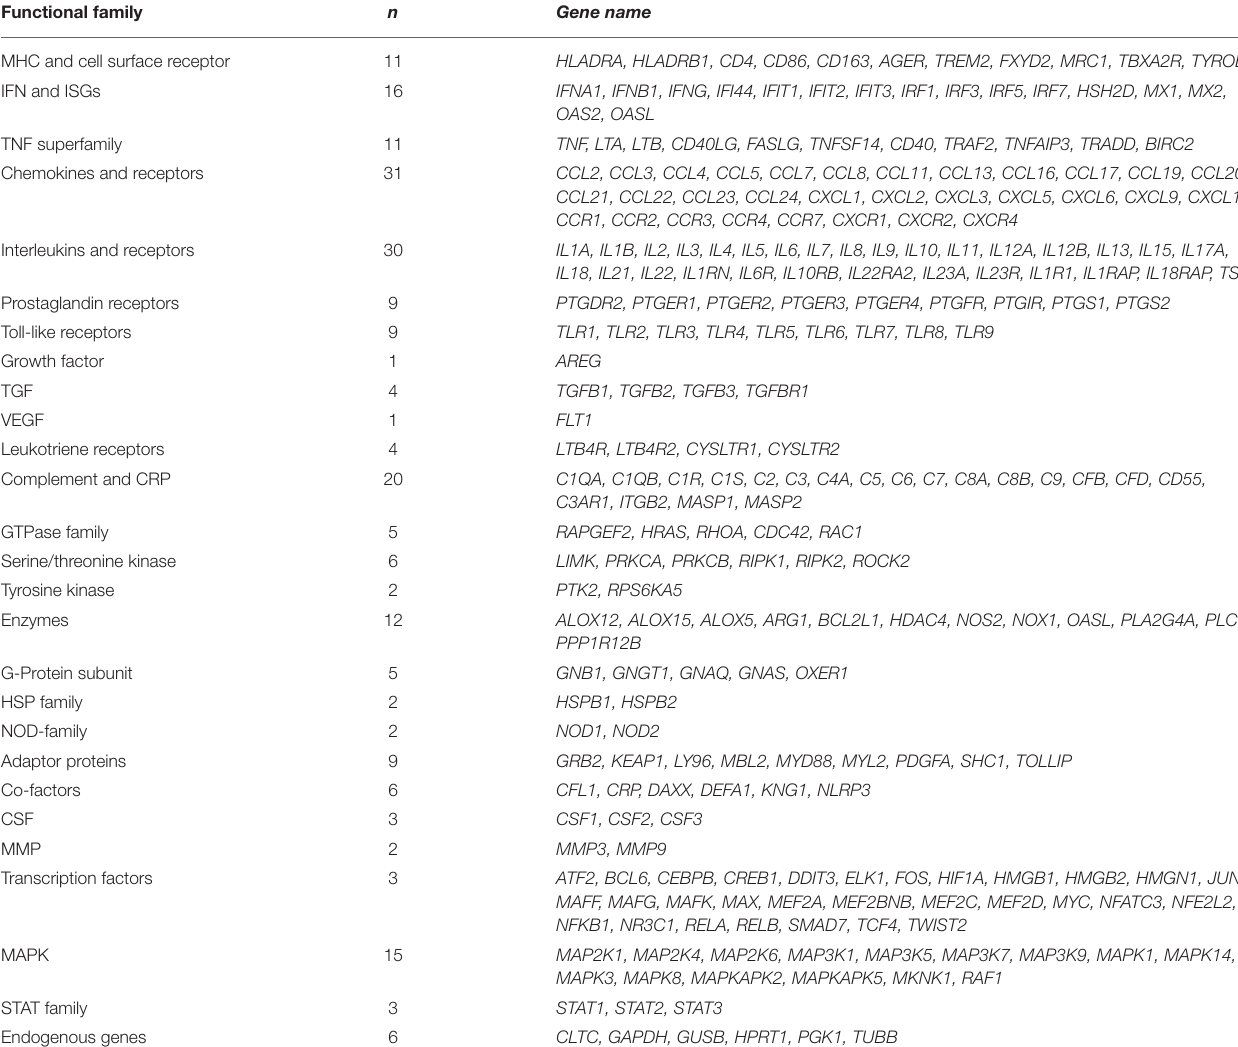
TABLE 1 | Gene expression CodeSet panel analyzed using nCounter ® Human Inflammation v2. Functional